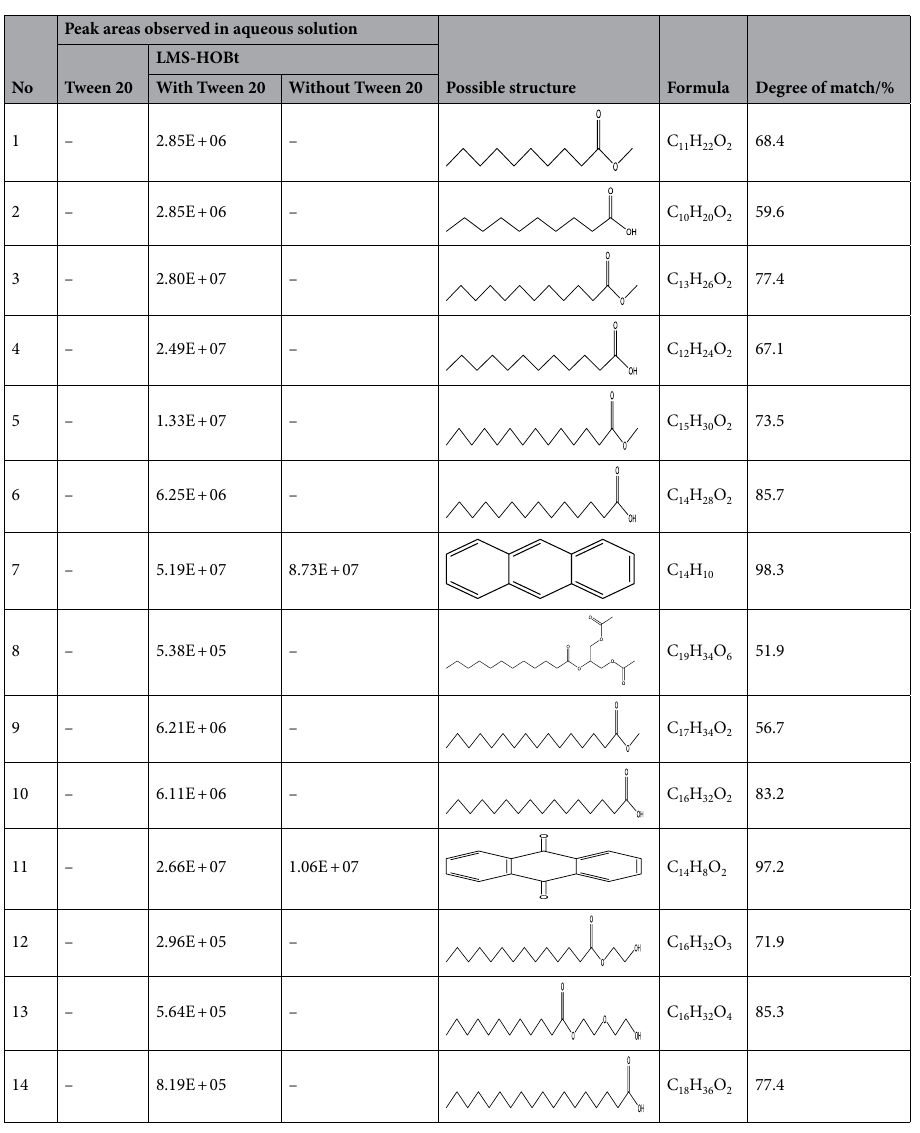
Table 3. Information of peak at the same time by possible products in both systems. Peak areas observed by GC/MS and possible formula of products produced with or without Tween 20 in LMS-HOBt and Tween